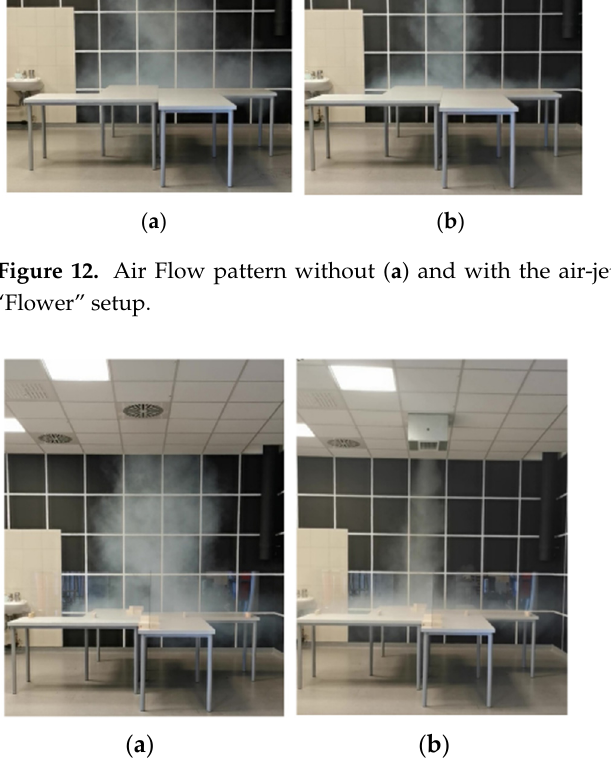
Figure 13. Air Flow pattern without ( a ) and with the air-jet control box ( b ) including plexiglass examined with the “Flower” setup. Table 3. Airflow status indicators at the Island of four setup.